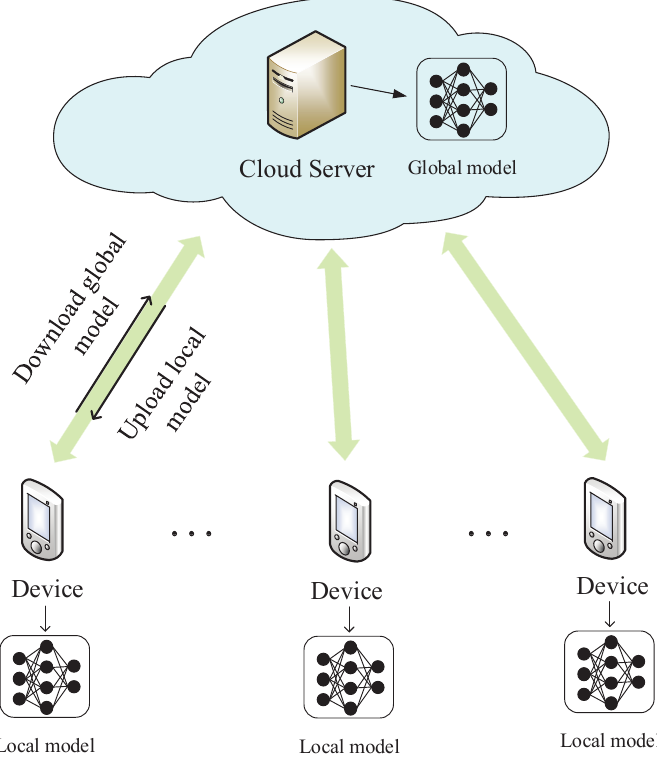
Figure 1. The framework of federated